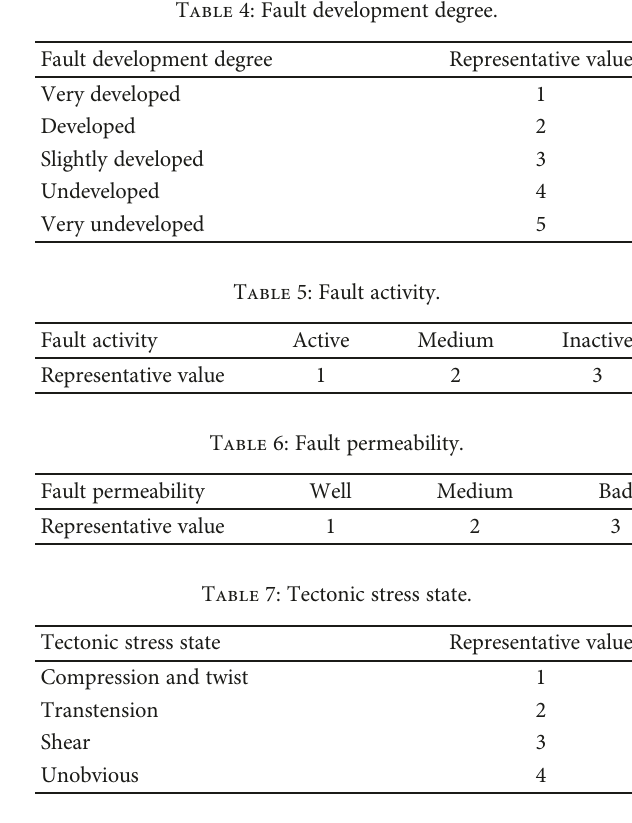
Table 8: Seismic activity